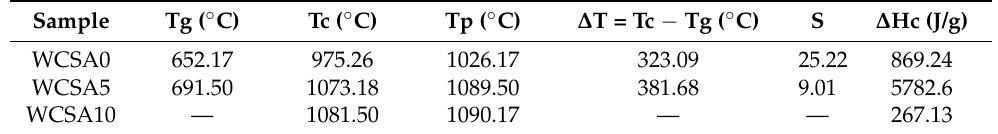
Table 2. DSC parameter value for WCS.